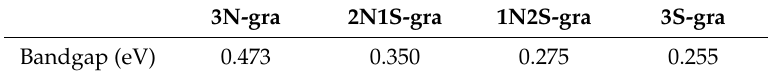
Table 1. The band gap energies Eg (in eV) for 3N-gra, 2N1S-gra, 1N2S-gra and 3S-gra